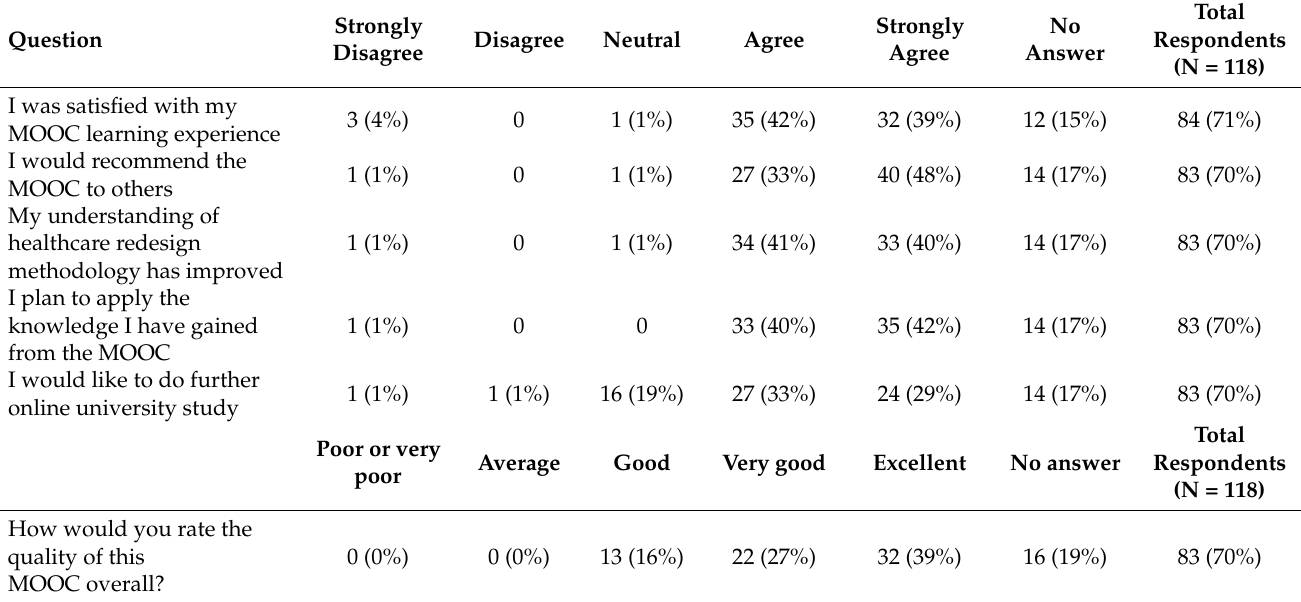
Table 4. Participant Experience Survey Questions including Perception of the Quality of the